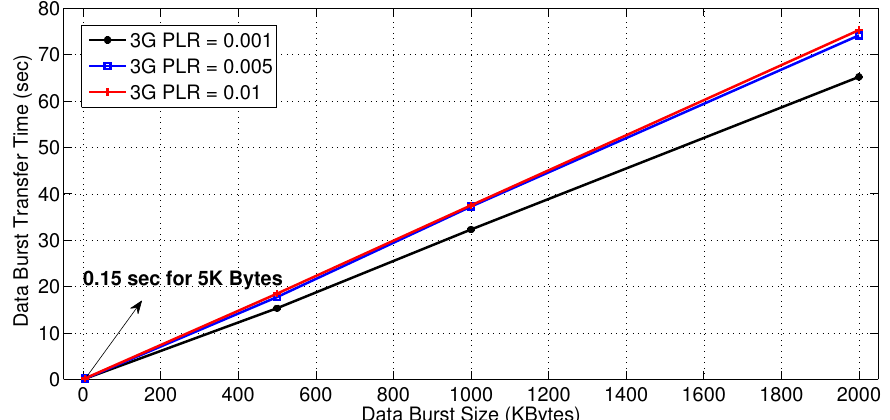
Figure 7. Data burst transfer time with different burst sizes and 3G